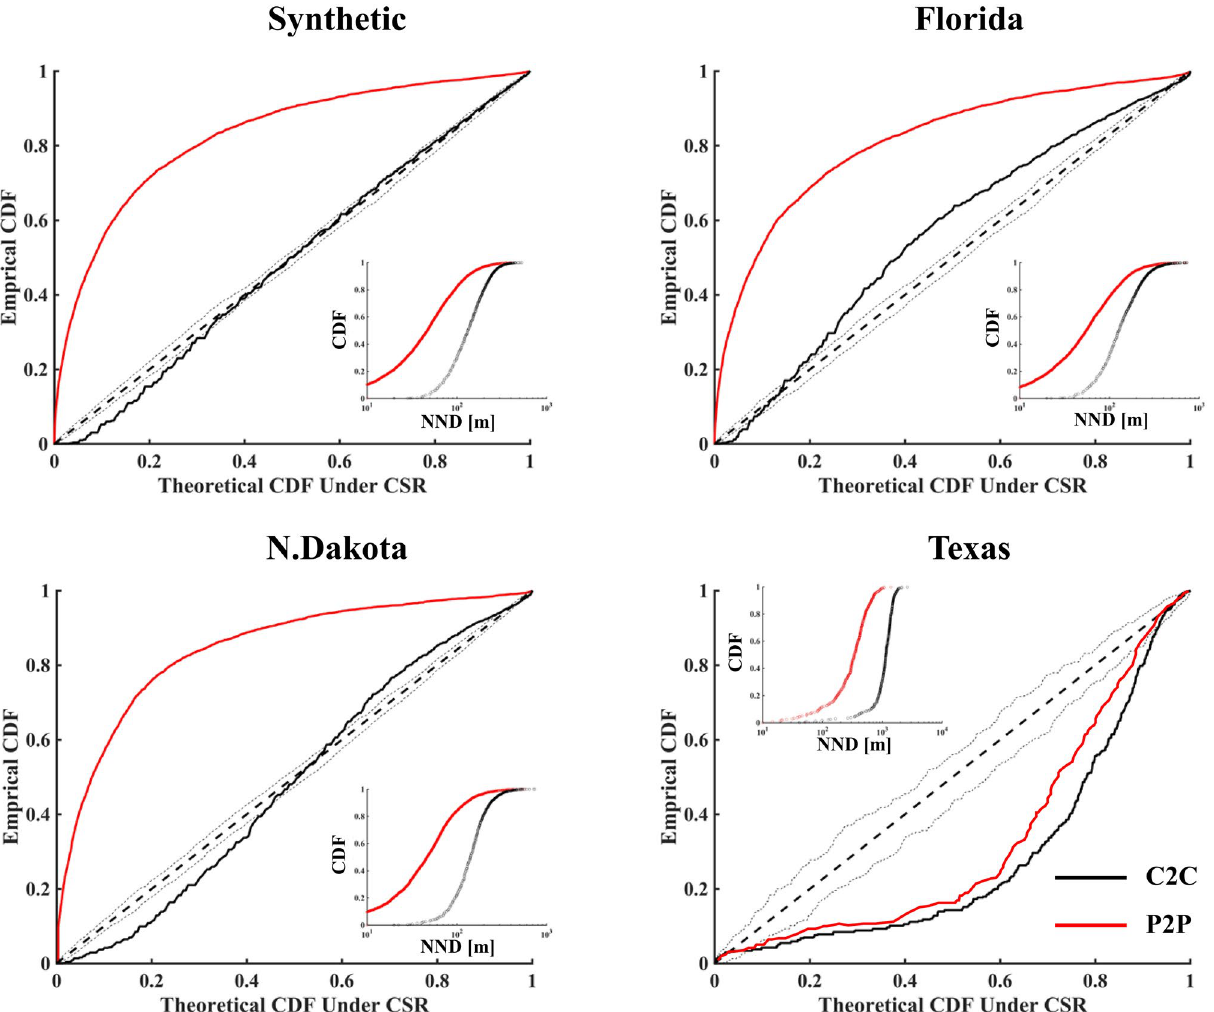
Figure 3. Comparison between the empirical distributions of C2C (black solid line) and P2P (red solid line) against the theoretical Poisson distribution prescribed by a CSR process. When the data follow the 1:1 line, the spatial point pattern is described by a CSR process. Dashed lines show the upper and lower envelopes for 99 simulation of CSR process. Data shown are for comparison between the C2C and P2P gap distances with z gw = z tp . Comparison between the CDF for nearest neighbor separation distance (NND) for both the C2C and P2P distance are shown as insets.